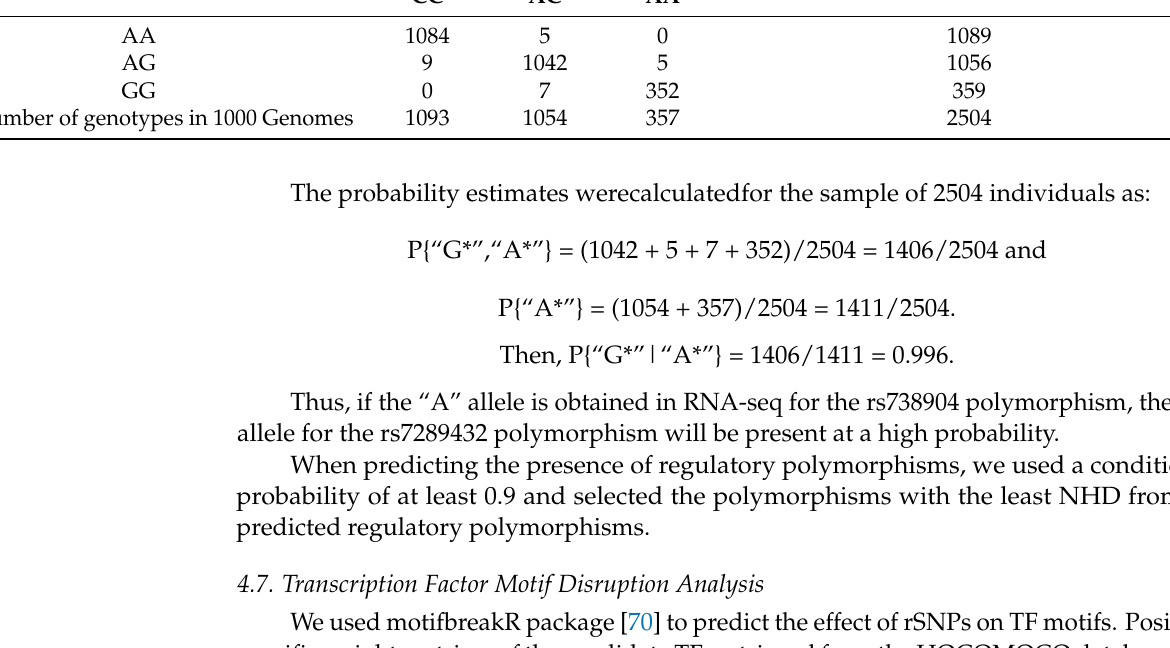
Table 3. Contingency table of the rs7289432 and rs738904genotypes for a sample of 2504 individuals from the 1000 Genomes dataset.